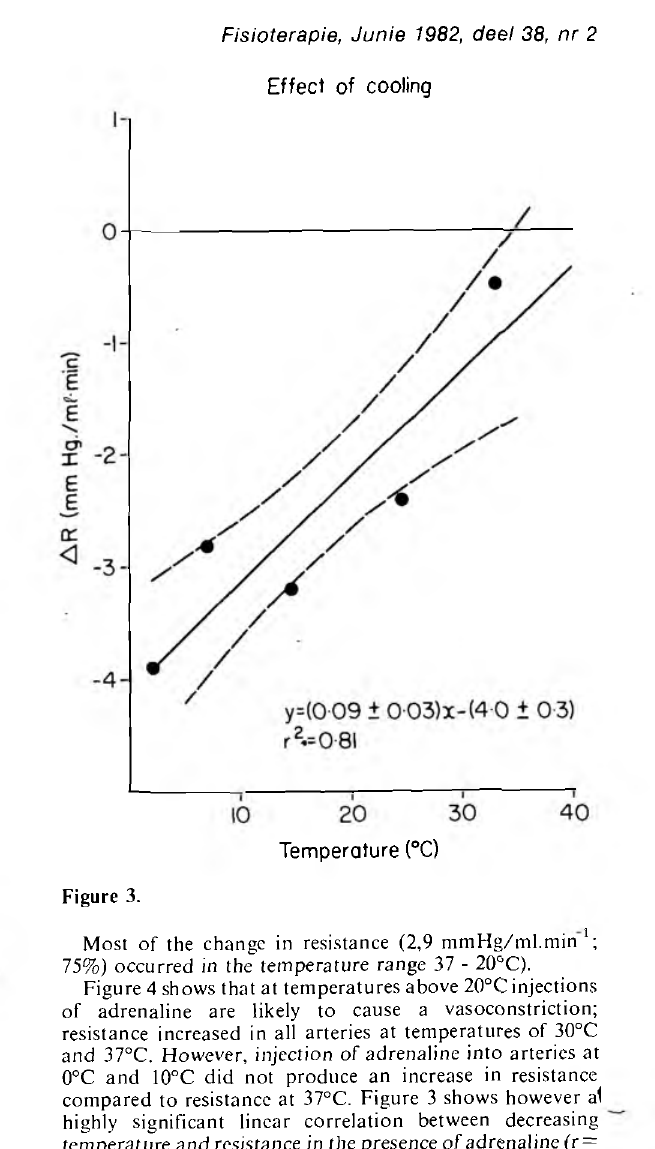
Temperature (°C) Figure 3. Most of the change in resistance (2,9 mmHg/ml.min 1; 75%) occurred in the temperature range 37 - 20°C). Figure 4 shows that at temperatures above 20°C injections of adrenaline are likely to cause a vasoconstriction; resistance increased in all arteries at temperatures of 30°C and 37°C. However, injection of adrenaline into arteries at 0°C and 10°C did not produce an increase in resistance compared to resistance at 37°C. Figure 3 shows however